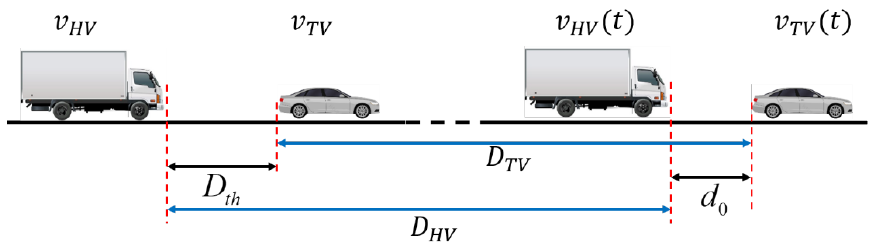
Figure 14. Vehicle distance diagram.